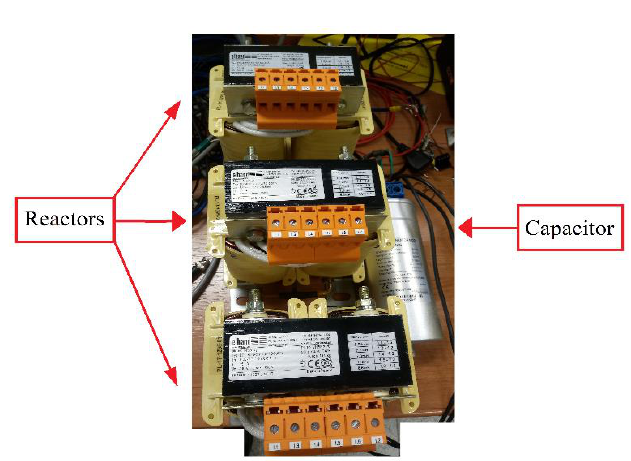
Figure A1. Three-phase capacitor bank and reactors (filter elements).